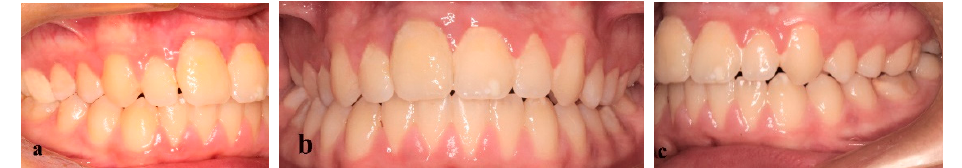
Figure 6. Intraoral final photographs. ( a – c ) Ankylosed incisor in the correct place and a small gingival discrepancy.